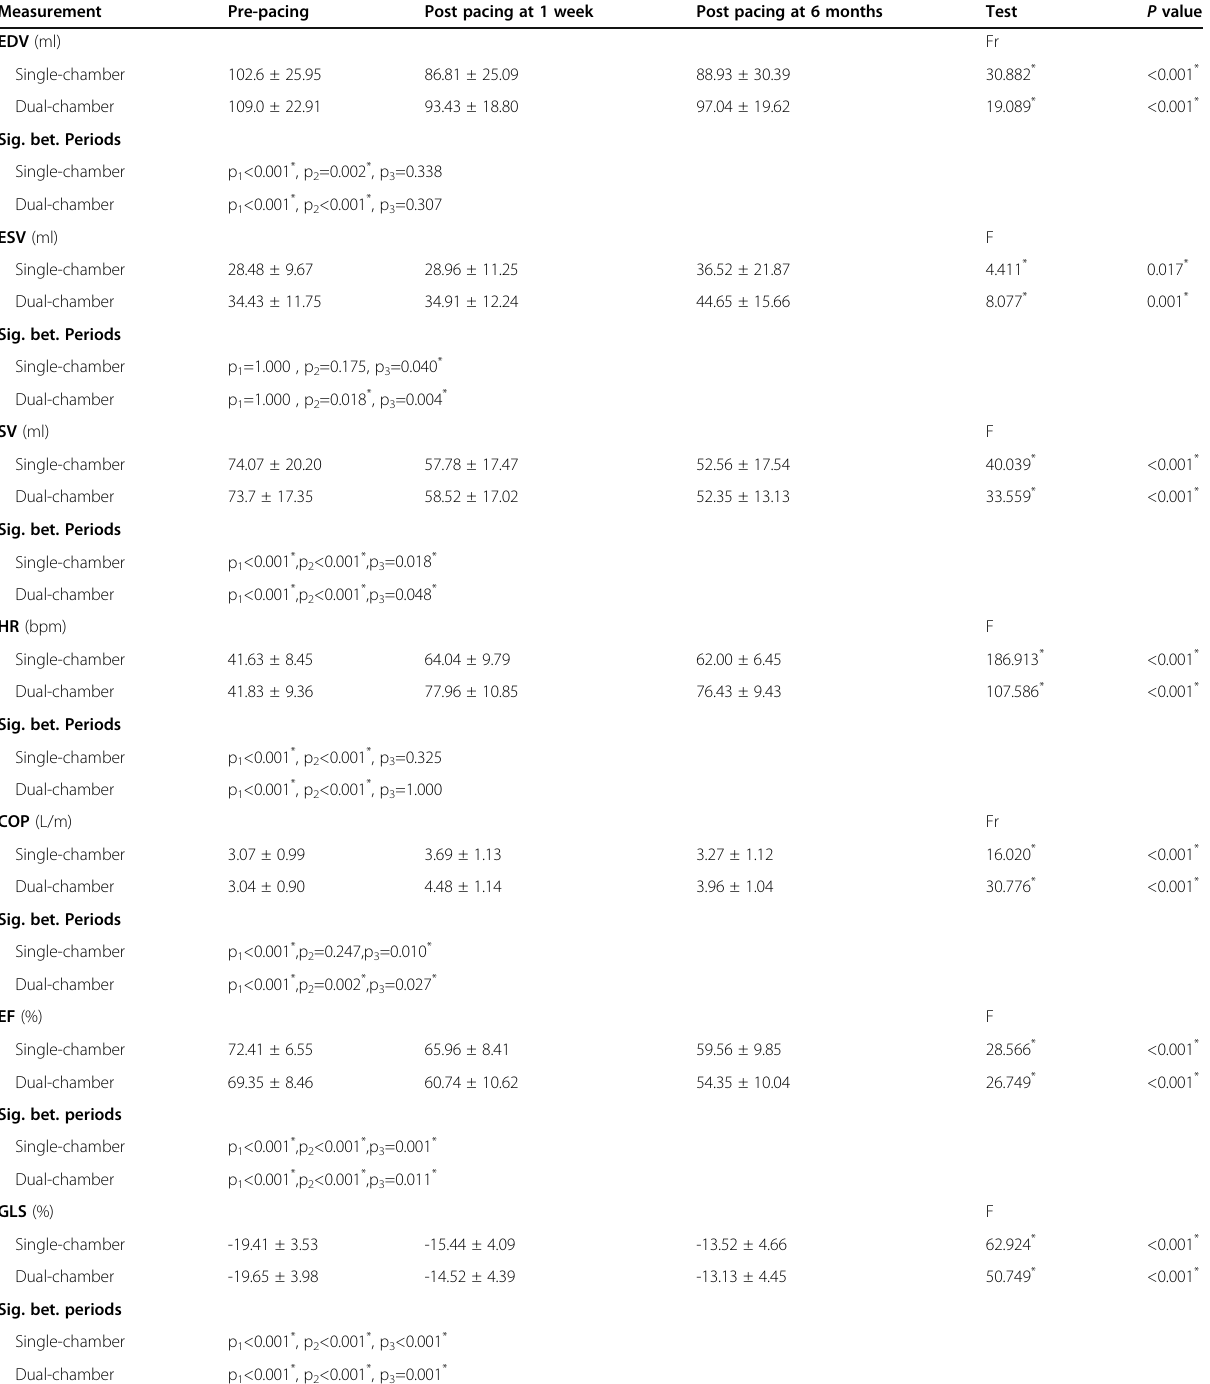
Table 4 Pacing related changes in all the measured parameters at the three time intervals (pre-pacing, at 1 week and 6 months post